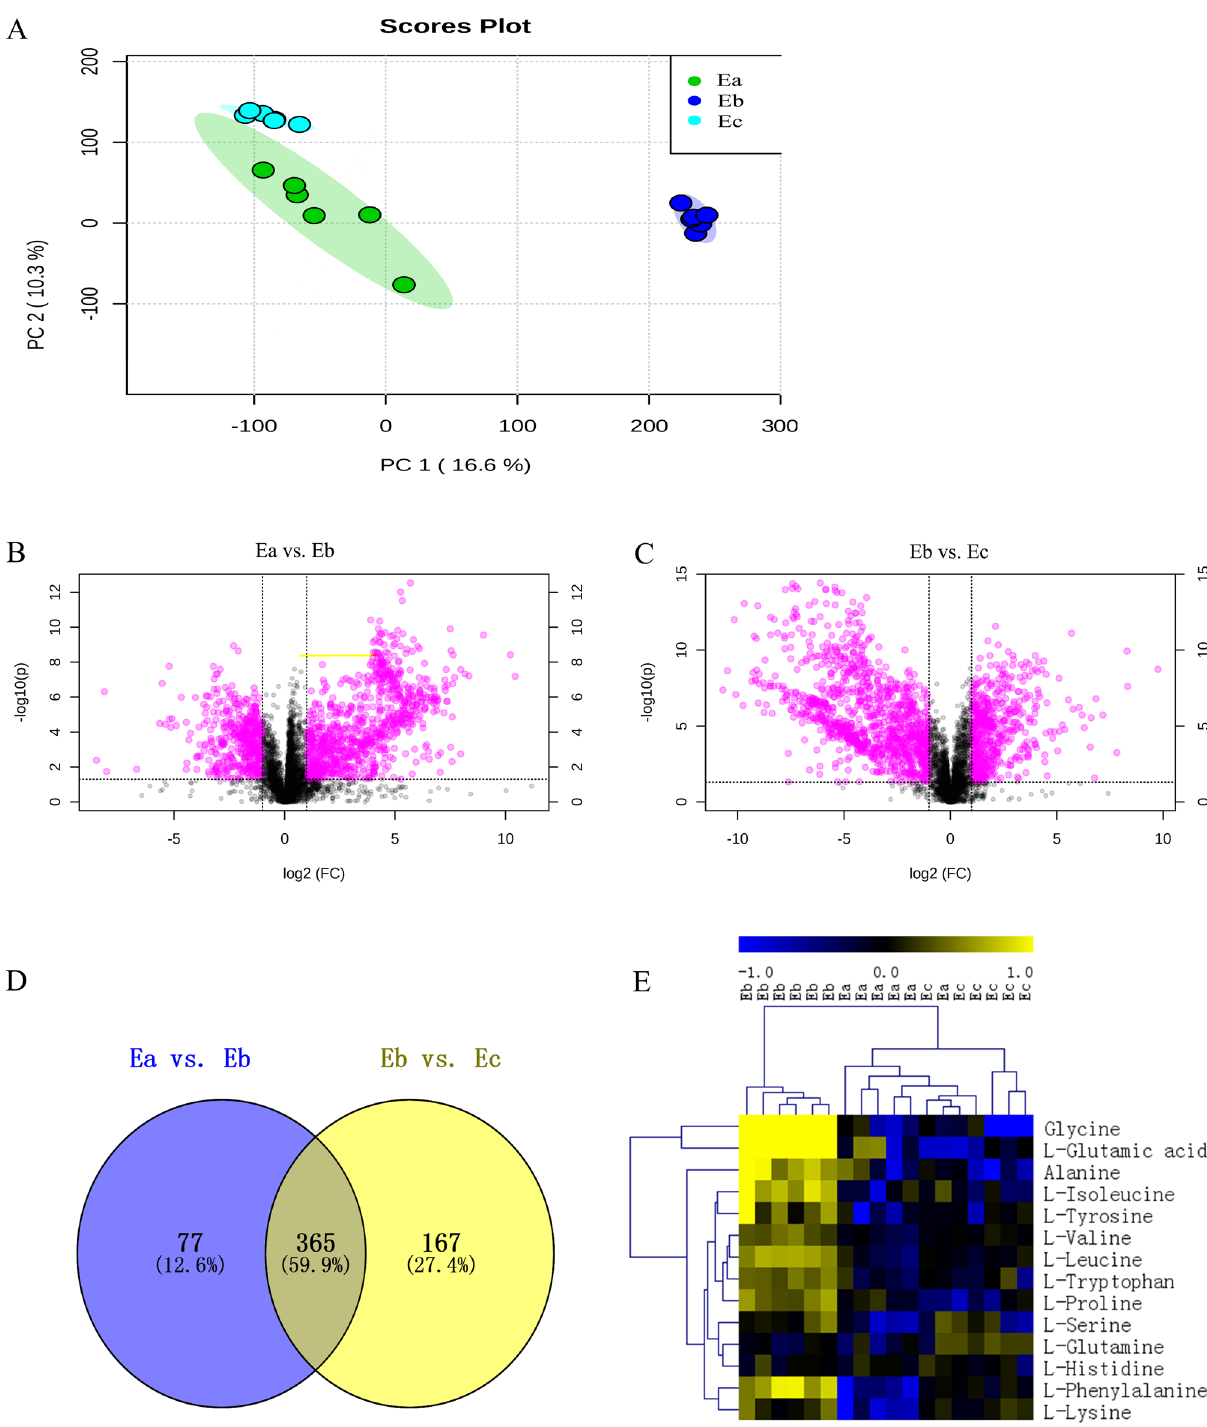
Figure 4. ( A ) Principal component analysis (PCA) of serum metabolite levels. ( B ) Volcano map of DEMs in E in stage a vs. stage b (False Discovery Rate (FDR) < 0.05, |fold change|> 2). ( C ) Volcano map of DEMs in E in stage b vs. stage c (False Discovery Rate (FDR) < 0.05, |fold change|> 2 ). ( D ) Venn analysis map of serum DEMs. ( E ) Cluster heat map of serum branched-chain amino acid and aromatic amino acid levels. ( E ) Serum, DEMs: differentially expressed metabolites, a: feeding period, b: fasting period, c: recovery feeding